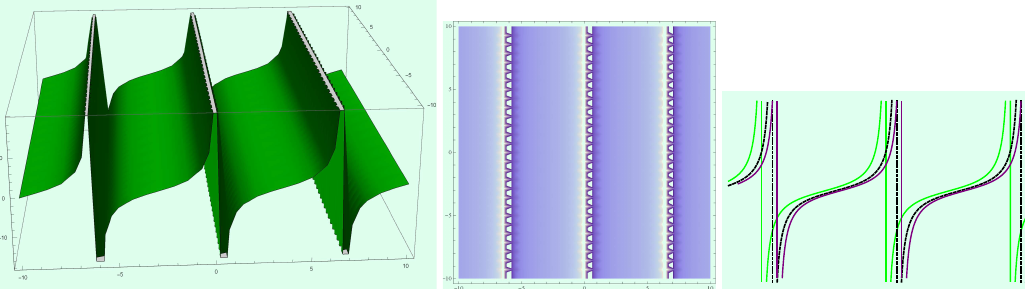
Figure 11. Profile of traveling wave solution (27) with parameters t = 0 and x = 3.